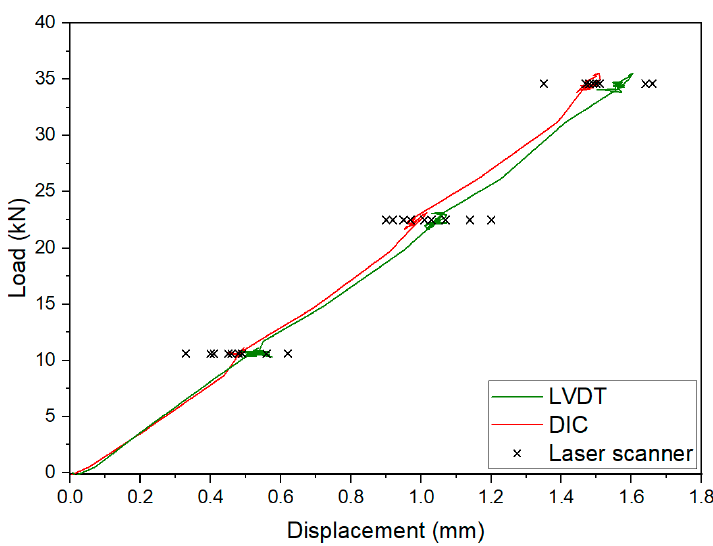
Figure 7. Static equilibrium path of the tested beam in the elastic range of displacements.